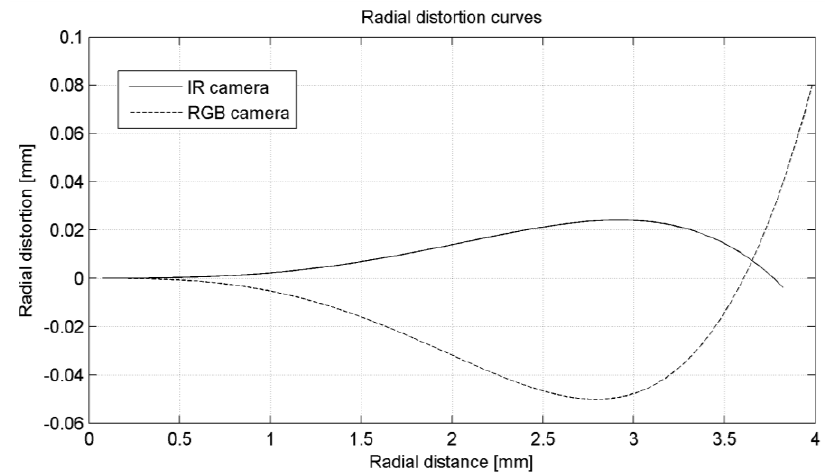
Figure 4. Radial distortion curves for the IR and RGB